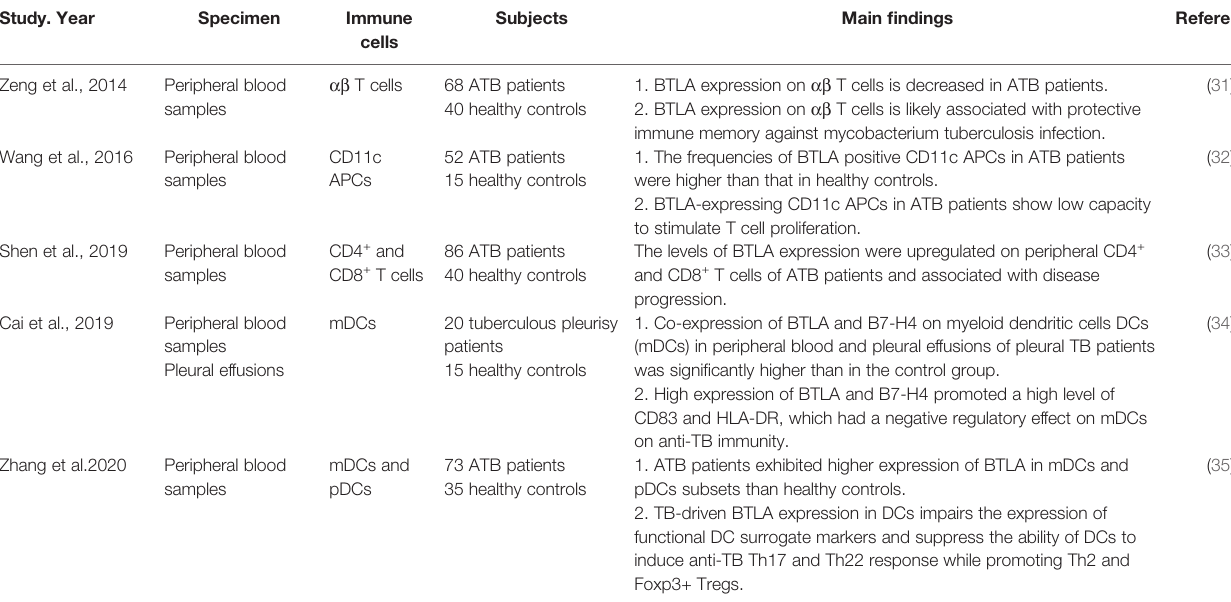
TABLE 2 | The function of BTLA in tuberculosis.